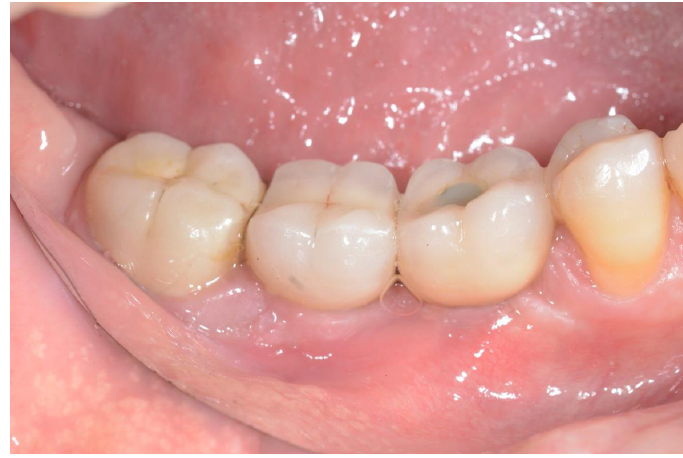
Figure 5. Clinical appearance at the 38-month follow-up. Periapical radiographs were taken at the 6-month and 12-month control visits and then yearly (Figures 6 and 7a,b).